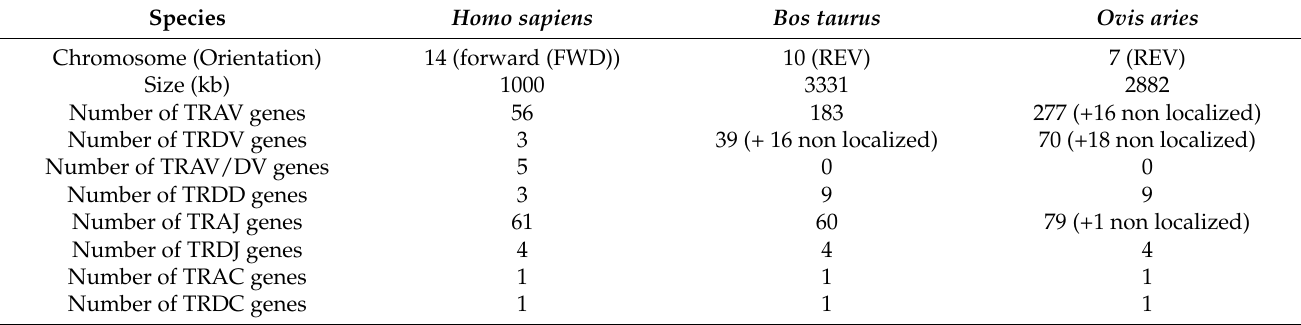
Table 1. Results of the analysis of TRA/TRD loci in human ( Homo sapiens ), bovine ( Bos taurus ) and sheep ( Ovis aries ). Species Homo